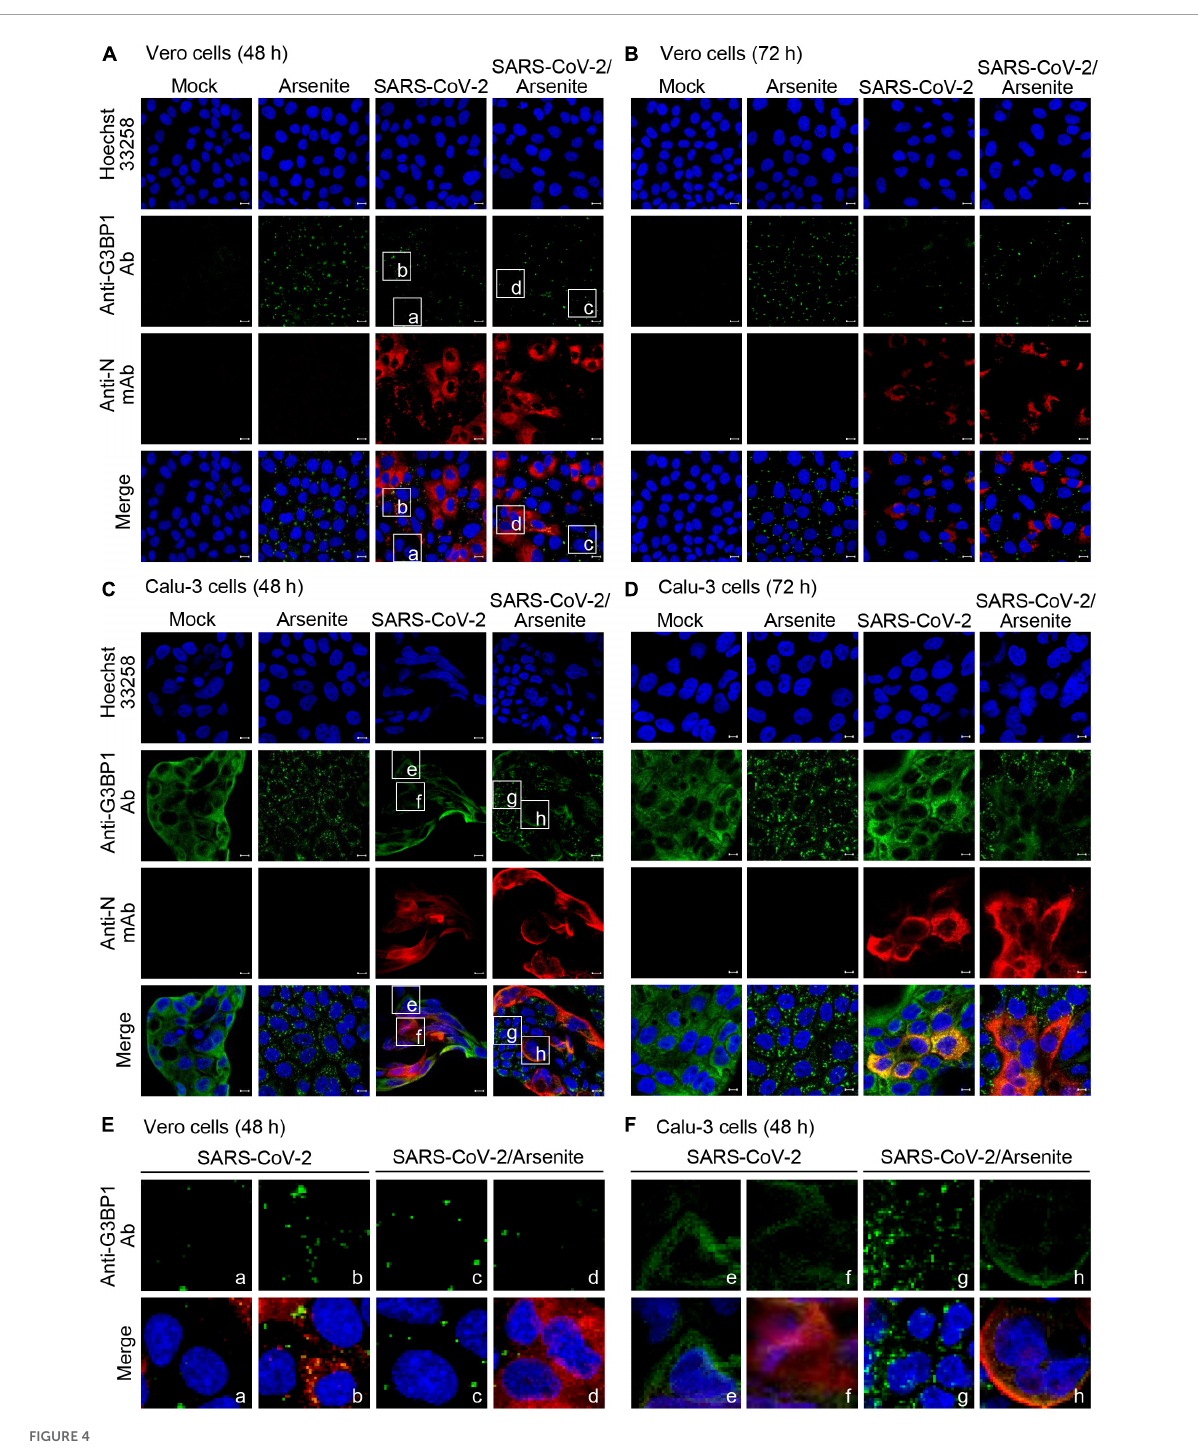
FIGURE4 Stress granule production in SARS-CoV-2-infected cells. Vero (A,B) and Calu-3 cells (C,D) were mock-infected or infected with SARS-CoV-2 S clade at 0.1 MOI and examined by immunofluorescence confocal microscopy at 48 h (A,C) and 72 h (B,D) post-infection. Cells were treated with 0.5 mM sodium arsenite or phosphate-buffered saline (PBS) control for 1 h, prior to fixing and staining with anti-GRBP1 antibody (green) and anti-SARS-CoV-2 N mAb (red). (E,F) Enlarged images. The boxed regions in A and C were magnified to show the relationship between N protein expression and stress granule formation. (E) Vero cells: cells not expressing N protein (a, c) were compared with N protein expressing cells (b, d). (F) Calu-3 cells: cells not expressing N protein (e, g) were compared with N protein expressing cells (f, h). Anti-N mAb, anti-SARS-CoV-2 N mAb (clone 1G10C4 mAb); Anti-N Ab, anti-SARS-CoV-2 N polyclonal Ab. Nuclei were stained with Hoechst 33258 (blue). Anti-N Ab, anti-SARS-CoV-2 N mAb (clone 1G10C4